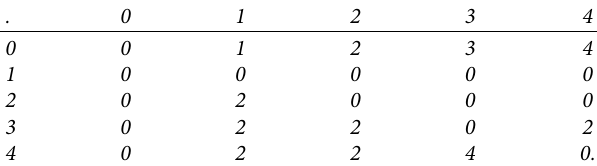
Table 1: UP-algebra which is not a KU-algebra.